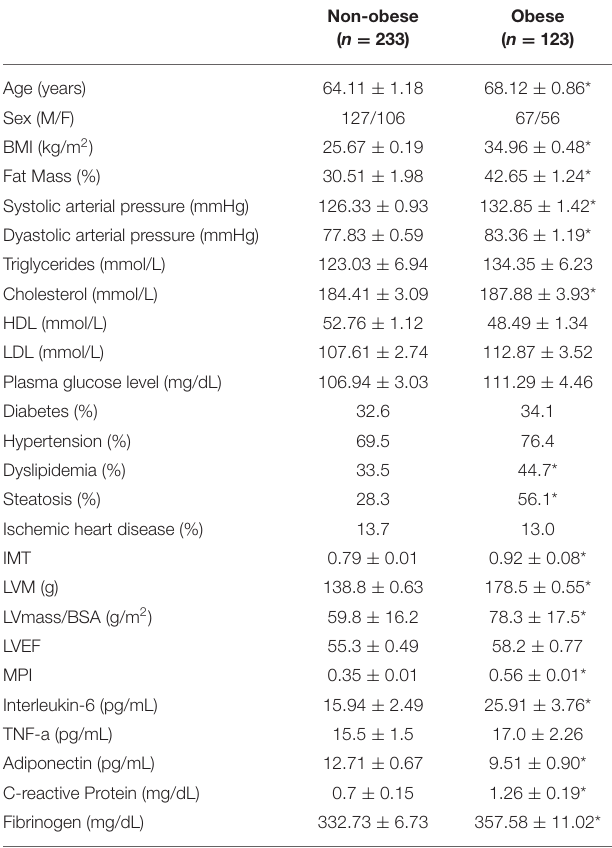
TABLE 1 | Clinical characteristic of study population ( n = 356).